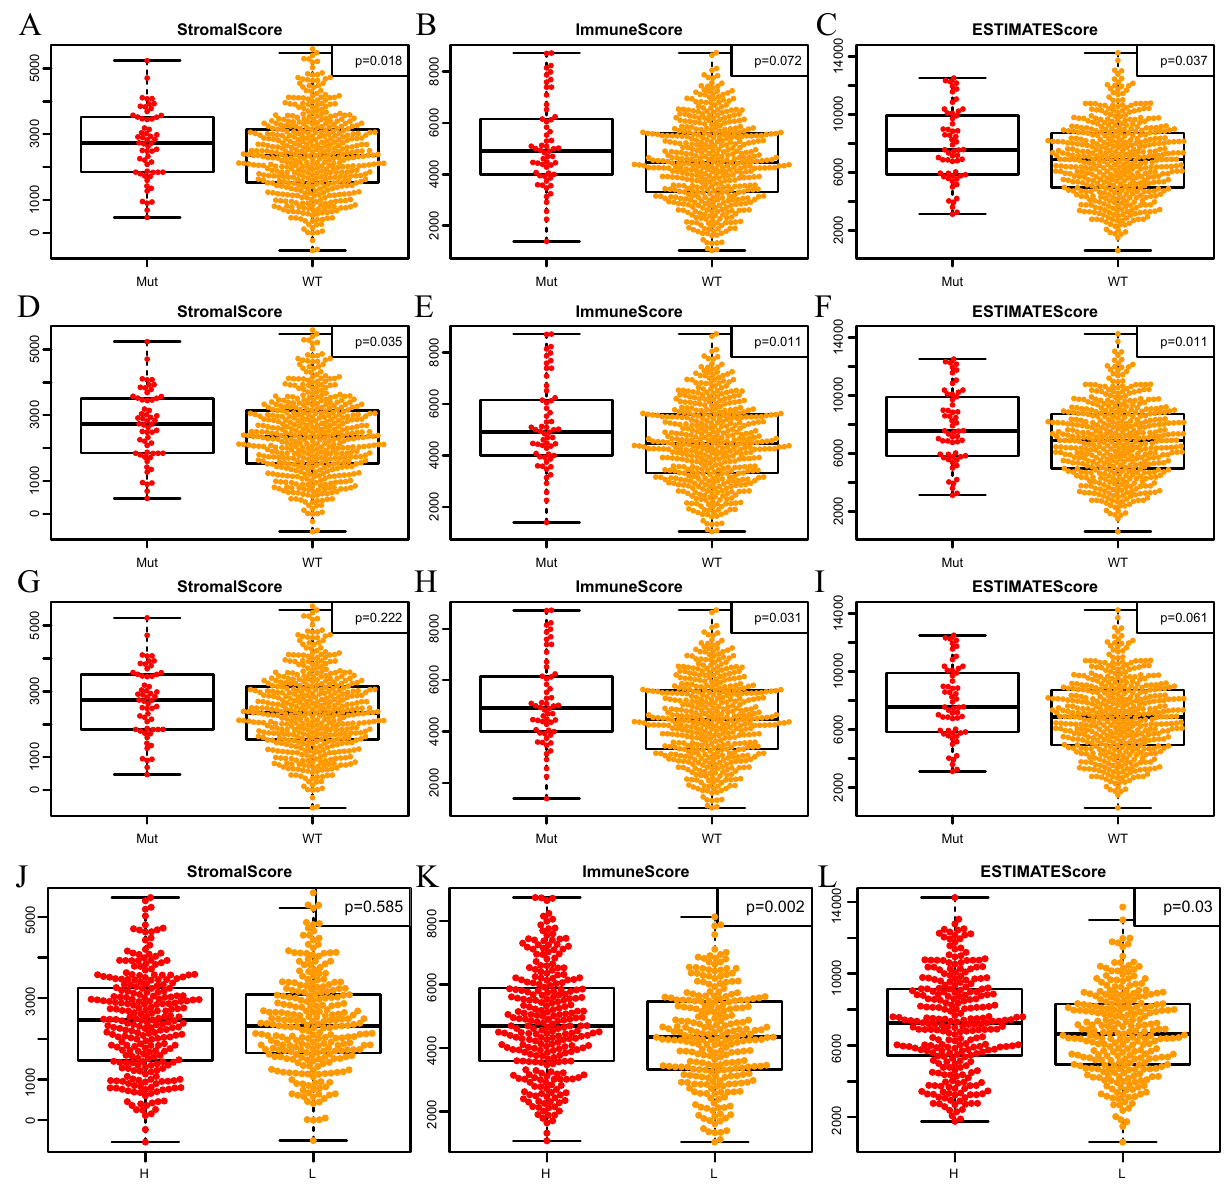
Figure 4. Correlations between ESTIMATE immune scores and gene mutations. The StromalScore in TP53 ( A ), BRCA1 ( D ) and BRCA2 ( G ) non-mutation and mutation groups. ImmuneScore in TP53 ( B ), BRCA1 ( E ) and BRCA2 ( H ) non-mutation and mutation groups. ESTIMATEScore in TP53 ( C ), BRCA1 ( F ) and BRCA2 ( I ) non-mutation and mutation groups. StromalScore ( J ), ImmuneScore ( K ) and ESTIMATEScore ( L ) in TMB- high and -low